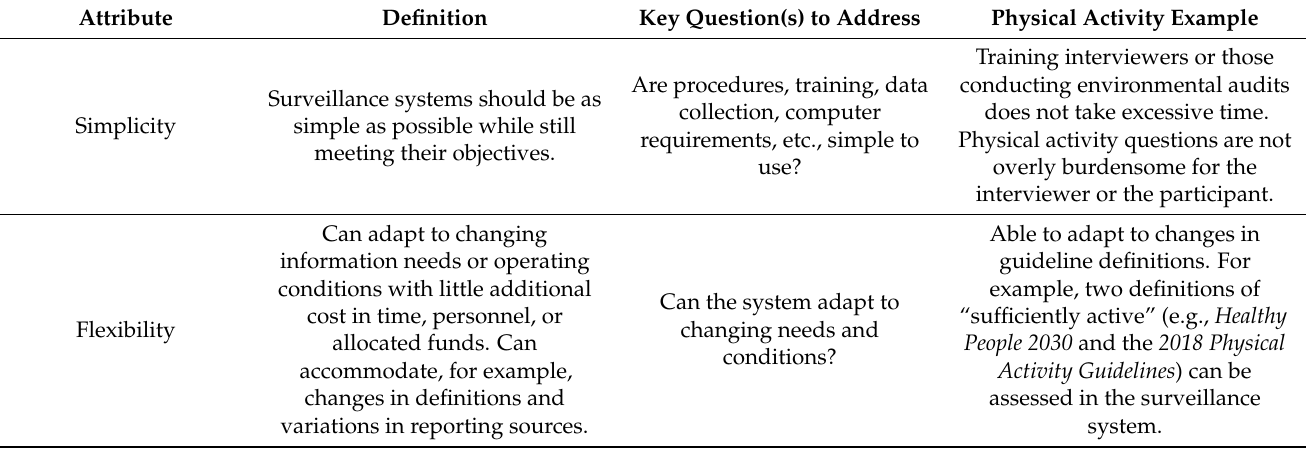
Table 1. Key attributes to consider when developing or evaluating public health surveillance systems